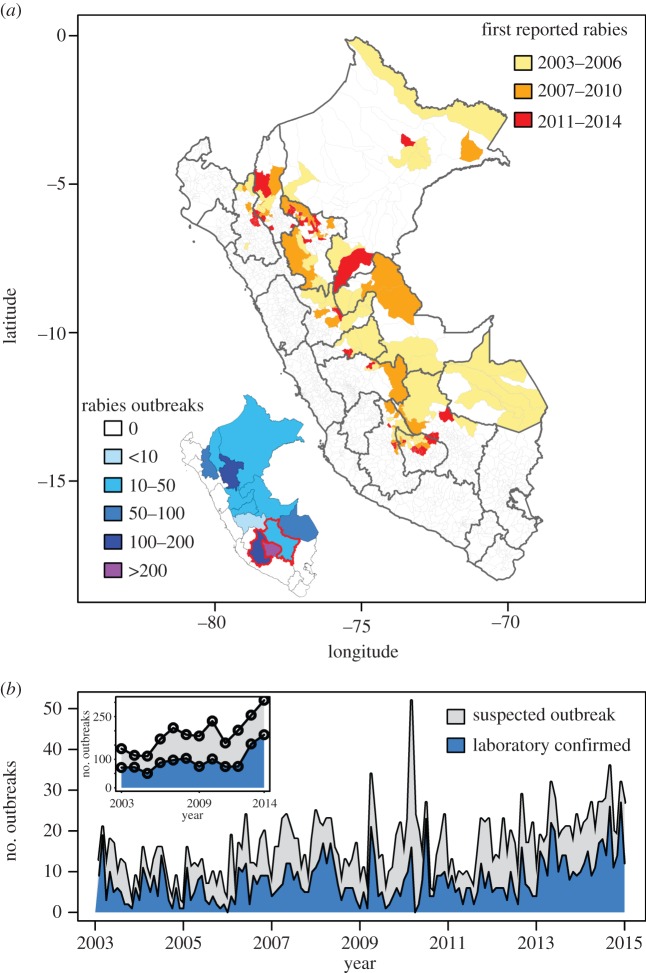
Spatial and temporal patterns of VBR outbreaks in Peru. (a) Times of VBR onset at the district level (main map) and the net number of confirmed outbreaks at the regional level (inset). Red lines show the AAC, including the Apurimac, Ayacucho and Cusco regions. (b) Pattern of monthly (main figure) and yearly (inset figure) outbreak reports across Peru, excluding regions where dog rabies is enzootic (Puno) and two regions on the coast (Lima and Ancash) that reported small numbers of unconfirmed outbreaks.